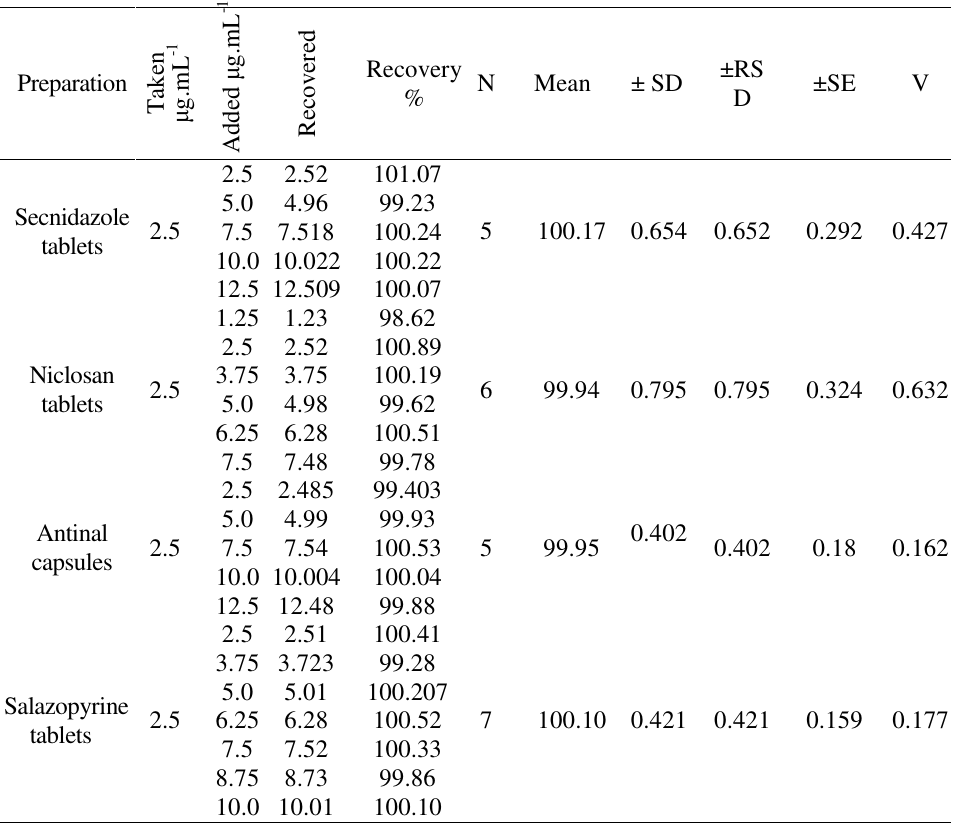
Table 4. Statistical analysis of results obtained by the proposed method for the studied drugs in their pharmaceutical preparations applying the standard addition technique.